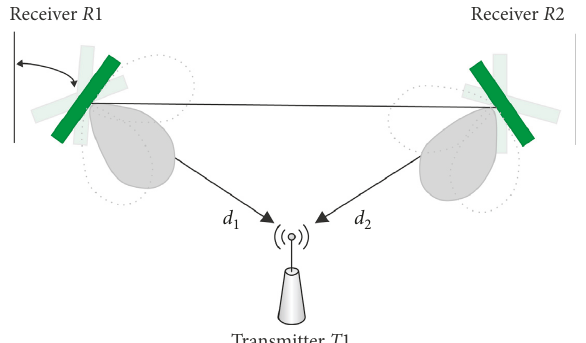
Figure 8: Schematic of multiple receivers of wireless